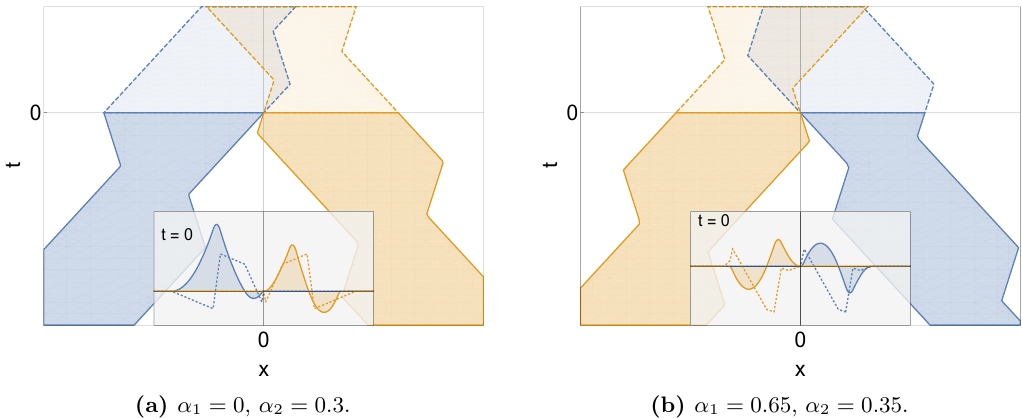
Figure 12 . Generic con(cid:12)gurations with v = 0 : 7 and V = 0 : 5. (a) shift by the right endpoint, (b) shift by the left